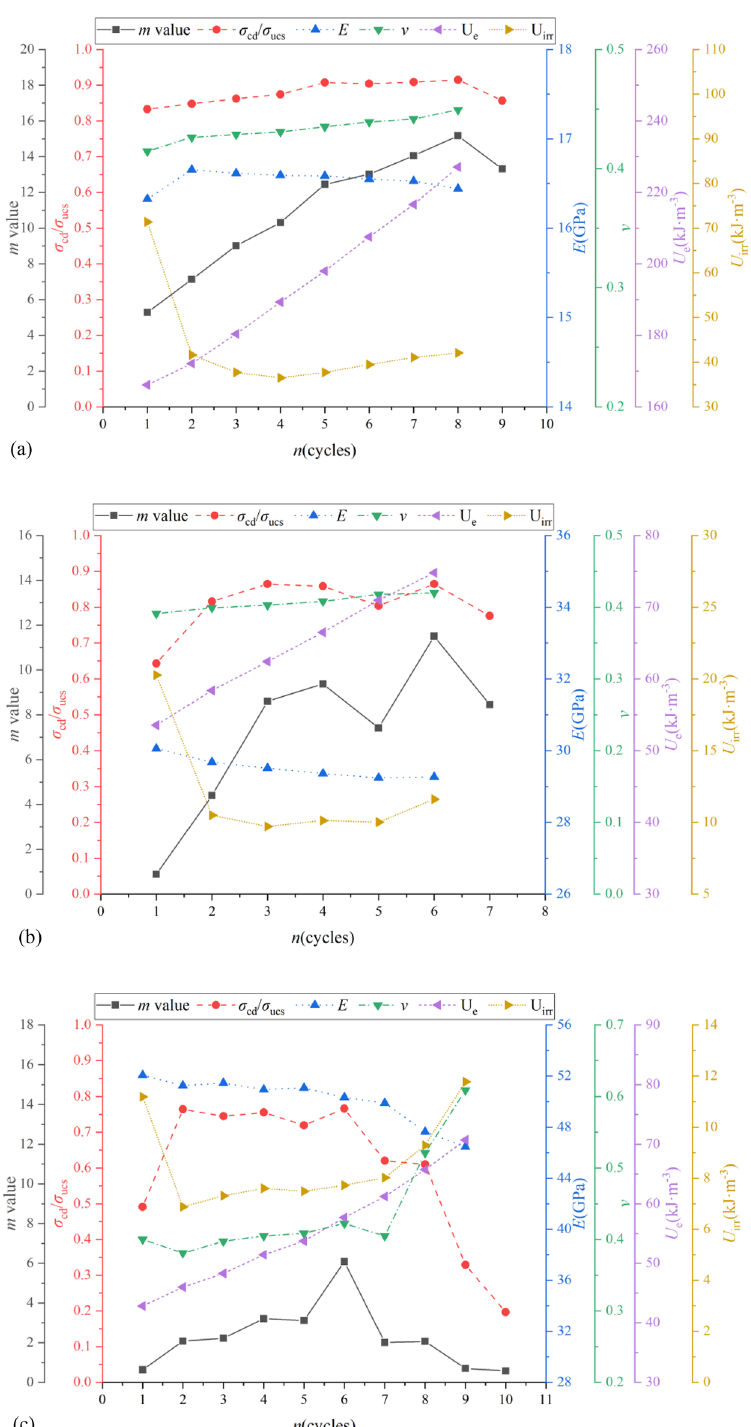
Figure 13. The relationship between m value and σ cd / σ ucs , E , ν , U e and U irr of shale specimens of group E with various dip angles: ( a ) θ = 0°; ( b ) θ = 60°; ( c ) θ =